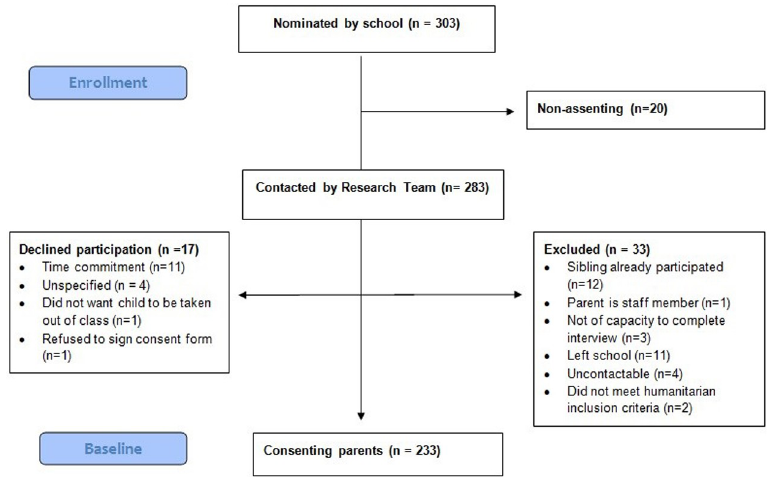
Fig 1. Flow diagram of parent participant